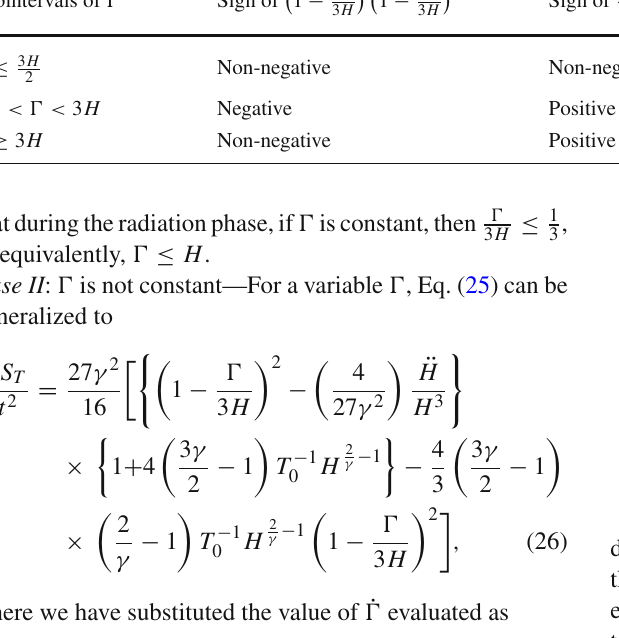
Table 1 Equilibrium configuration for different subintervals of (cid:2) Subintervals of